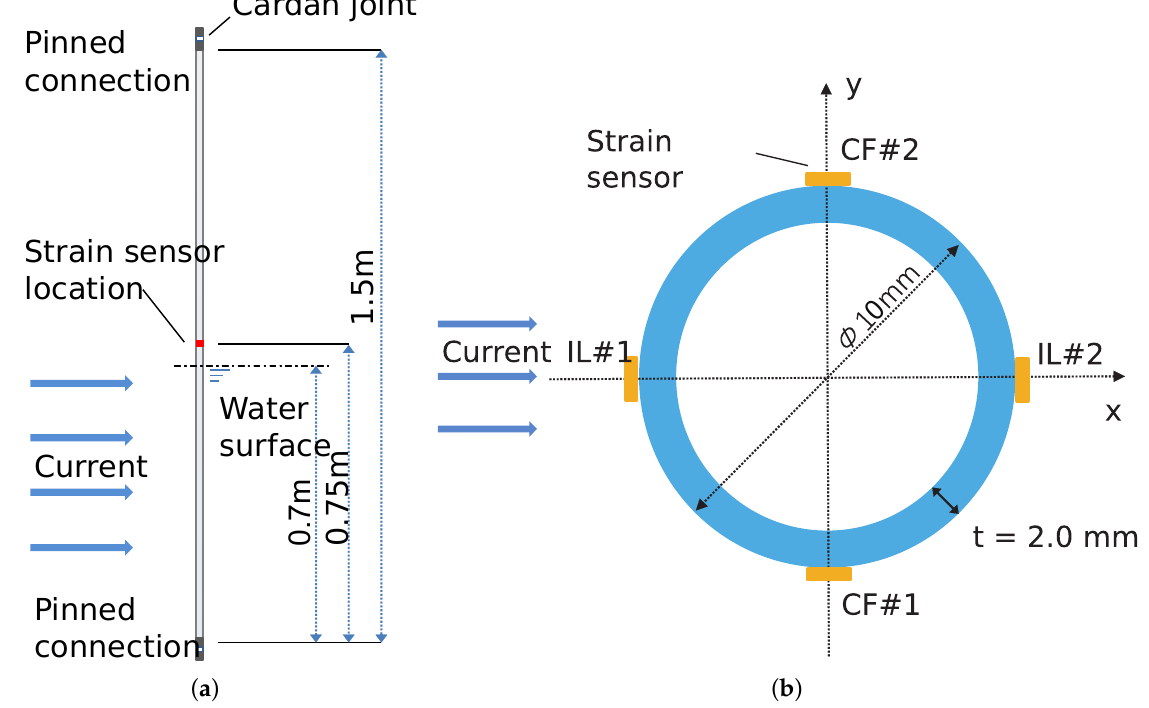
Figure 10. Strain sensor arrangement: ( a ) a side view of a pipe; and ( b ) four strain sensors attached on the circumference of the pipe at its mid-span